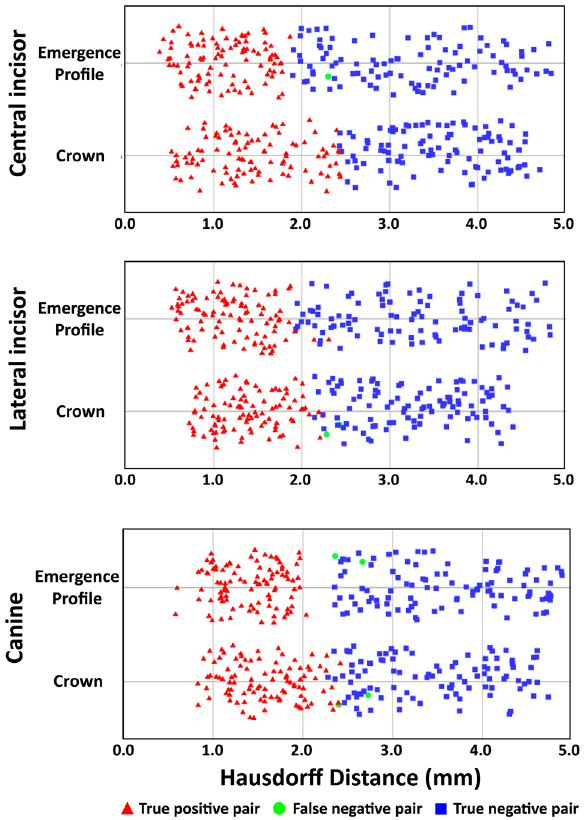
Figure 2. Jitter plot of 3D HDs for central incisor, lateral incisor, and canine pair comparisons. A true positive pair indicates a contralateral element, from the same individual, that was correctly categorized as a pair. For the distribution of true negative pairs, the smallest 100 data points among the 9900 comparisons were illustrated.